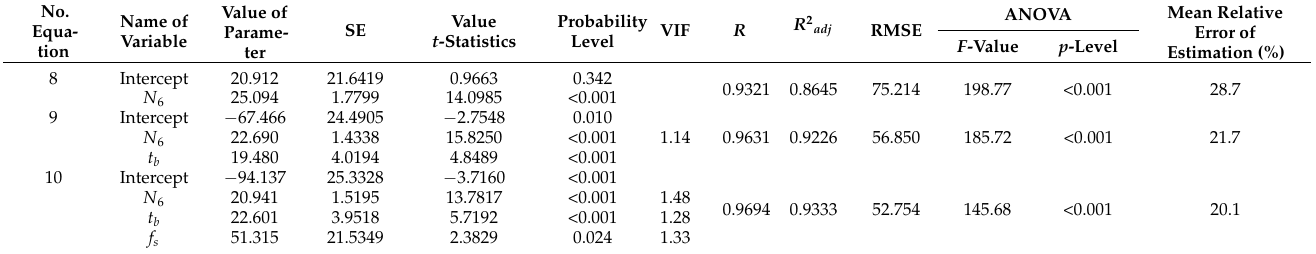
Table 3. Parameters and basic statistics for Equations